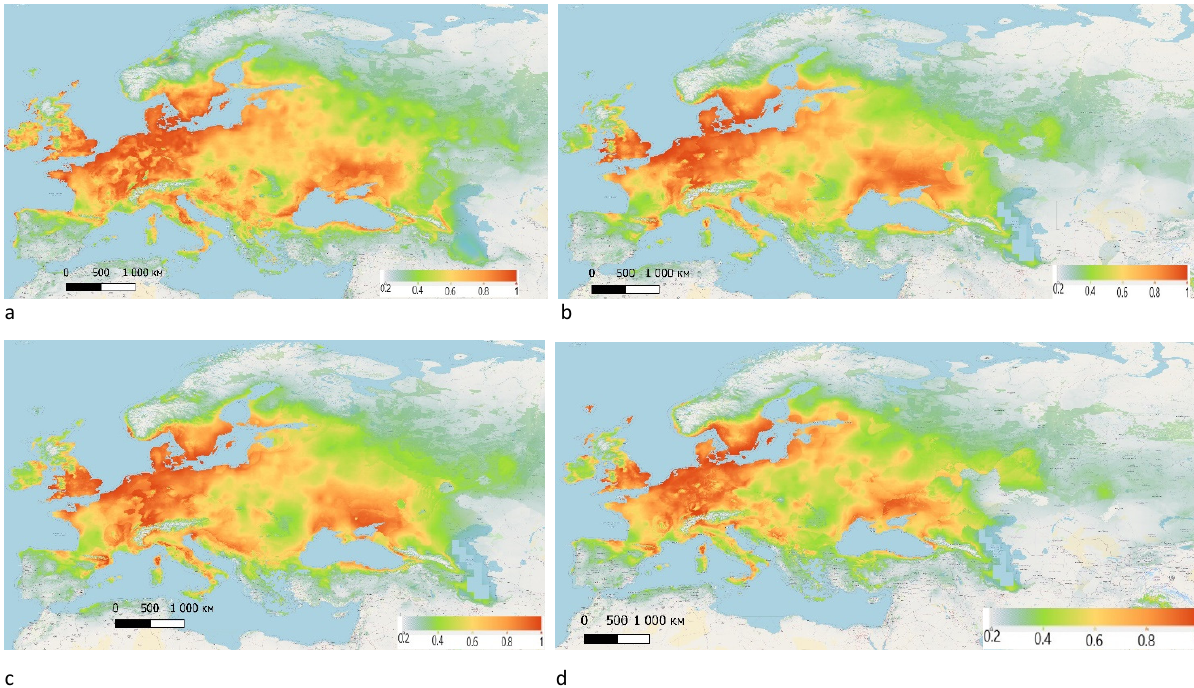
Figure 8. The predicted bioclimatic ranges of H. rufipes : ( a ) 2050, according to RCP 2.6 scenario; ( b ) 2070, according to RCP 2.6 scenario; ( c ) 2050, according to RCP 8.5 scenario; ( d ) 2070, according to RCP 8.5 scenario.